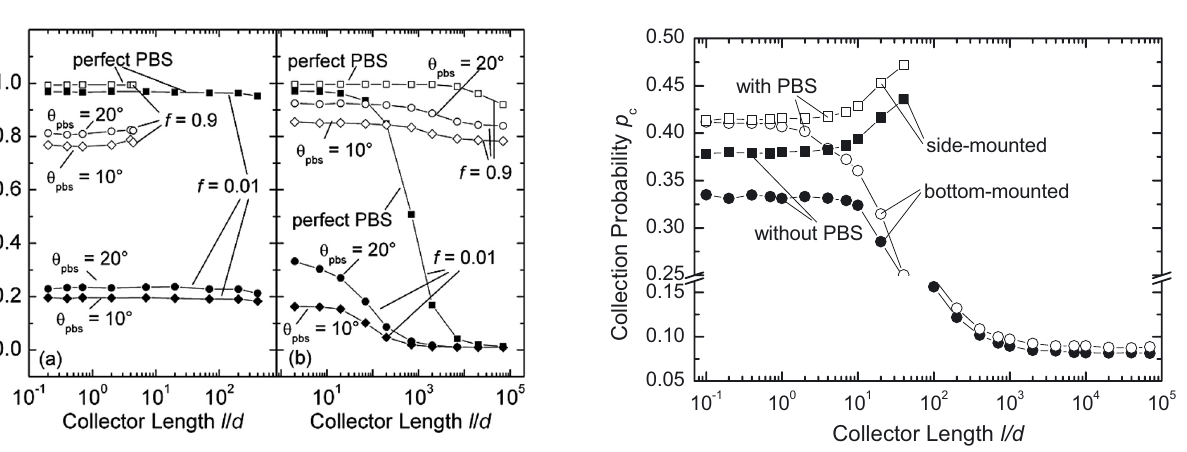
Fig. 11. Side-mounted and bottom-mounted solar cells on flu- orescent collectors including realistic values for the back side mirror, the photonic structure and the fluorescent dye. The bottom-mounted solar cells are in the small-scale limit for l/d < 1 and in the large-scale limit from l/d > 10 3 . For a clear acrylic glass on top of the solar cells, the coverage frac- tion f = 0 . 1 leads to a collection probability p c = 0 . 1. Thus, a fluorescent collector system with the assumed losses increases the collection probability by 23%, with a PBS on top by 27%. The side-mounted solar cells show an interesting behavior for l/d > 11. Instead of descending into the large-scale limit, p c increases up to 0.47 at l/d > 40 (with PBS on